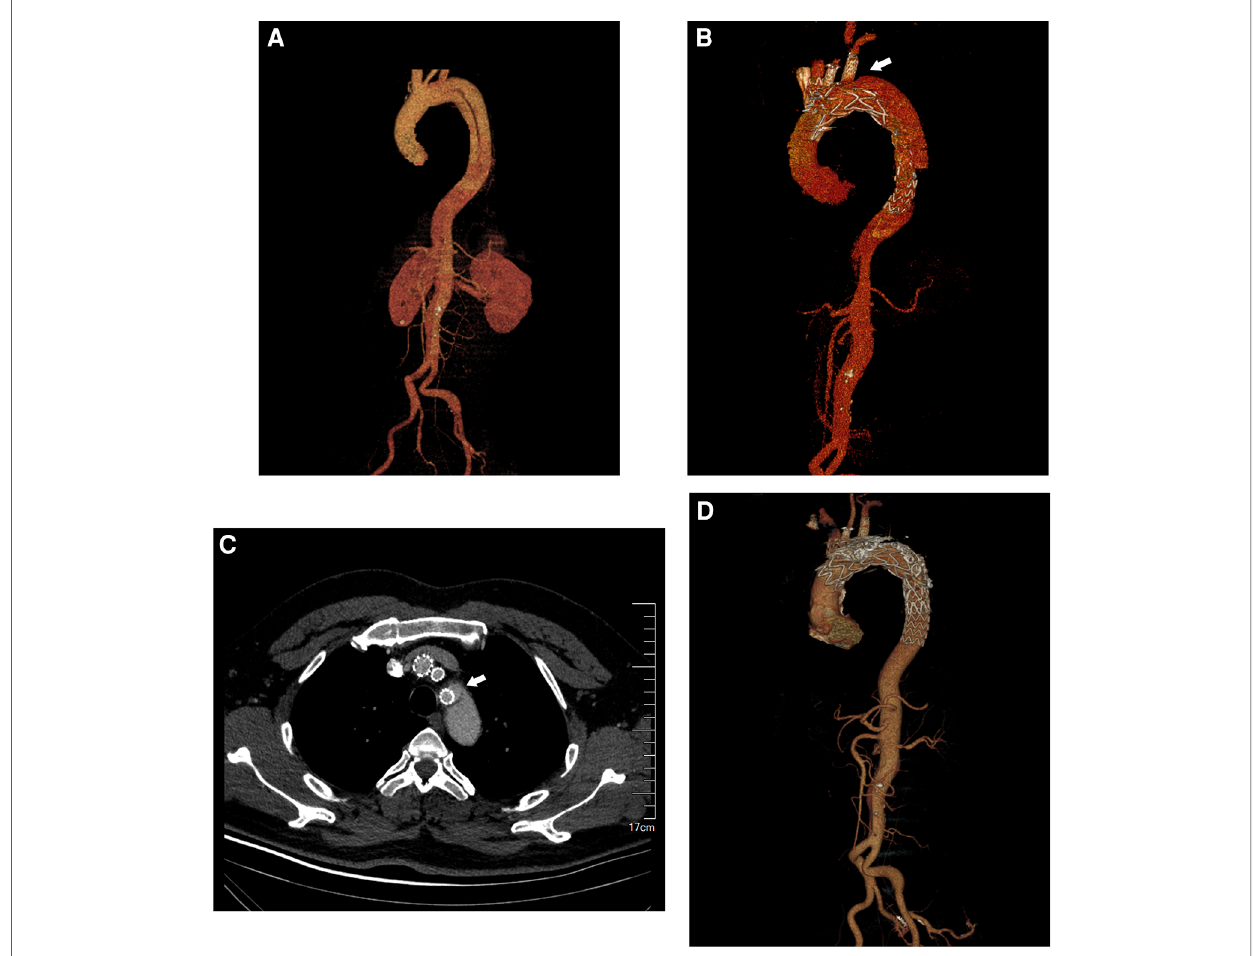
FIGURE 1 A 45-year-old male patient underwent fb-arch repair for chronic aortic dissection. The patient developed type IIIc endoleak around the left subclavian artery during the follow-up. ( A ) The CTA imaging of the aortic arch involved by dissection. ( B ) The CTA imaging of the Type IIIc endoleak near the left subclavian artery after fb-arch repair. (arrow). ( C ) The cross-sectional image of the Type IIIc endoleak (arrow). ( D ). After two false lumen coil embolization, the original endoleak disappeared and the aorta was well